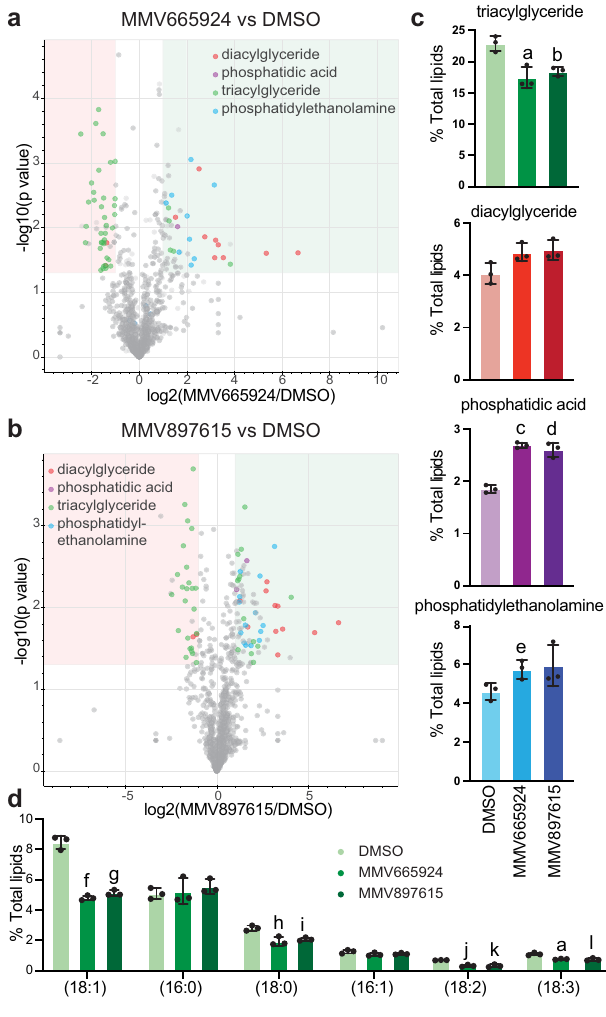
Fig. 8 | Drug treatment inhibits diacylglycerol to triacylglycerol conversion in trophozoites. Young 3D7 trophozoites were enriched based on their magnetic binding to MACS columns and were treated with DMSO, 10mM MMV665924 or 1mM MMV897615 for 8h. Lipids were extracted and submitted for Liquid Chro- matography / Mass Spectrometry (LC/MS). Three biological replicates were per- formed, and results of each sample were normalized to total lipid composition of the sample. Volcano plots showing lipid species for DMSO-treated parasites vs MMV665924( a )orMMV897615( b ),lipidspeciesthataremorethan2-folddifferent and have a p value <0.05 (two-sided unpaired Student ’ s t test) are shaded. c Changes in relevant lipid subclasses upon drug treatment compared to DMSO control. d ThecontributionofeachindividualFAspeciestothetotalTAGpoolwas analyzedandcomparedbetweentheDMSOcontrolandthedrug-treatedparasites. Data are shown for the six most frequently detected FAs. Results were obtained from three biological replicates and are shown as means±SD. Differences were tested using a two-sided unpaired Student ’ s t test. a: p =0.01, b: p =0.006, c: p =0.00009, d: p =0.001, e: p =0.04, f: p =0.0002, g: p =0.0003, h: p =0.004, i: p =0.003,j: p =0.0008,k: p =0.002,l: p =0.008.Thecompletedataareavailable in Supplementary Data 9 and 11, and in the Source Data fi le. FA fatty acid, TAG